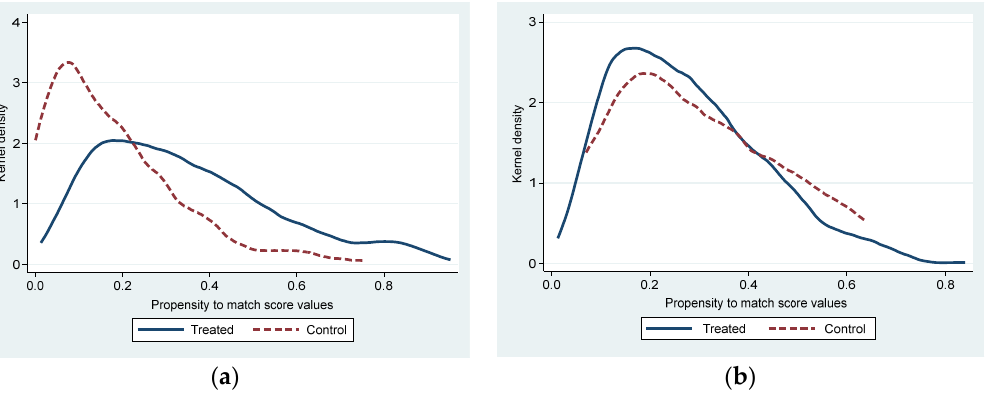
Figure 4. Common values before and after PSM treatment (2015). ( a ) Kernel density before PSM, ( b ) Kernel density after PSM.